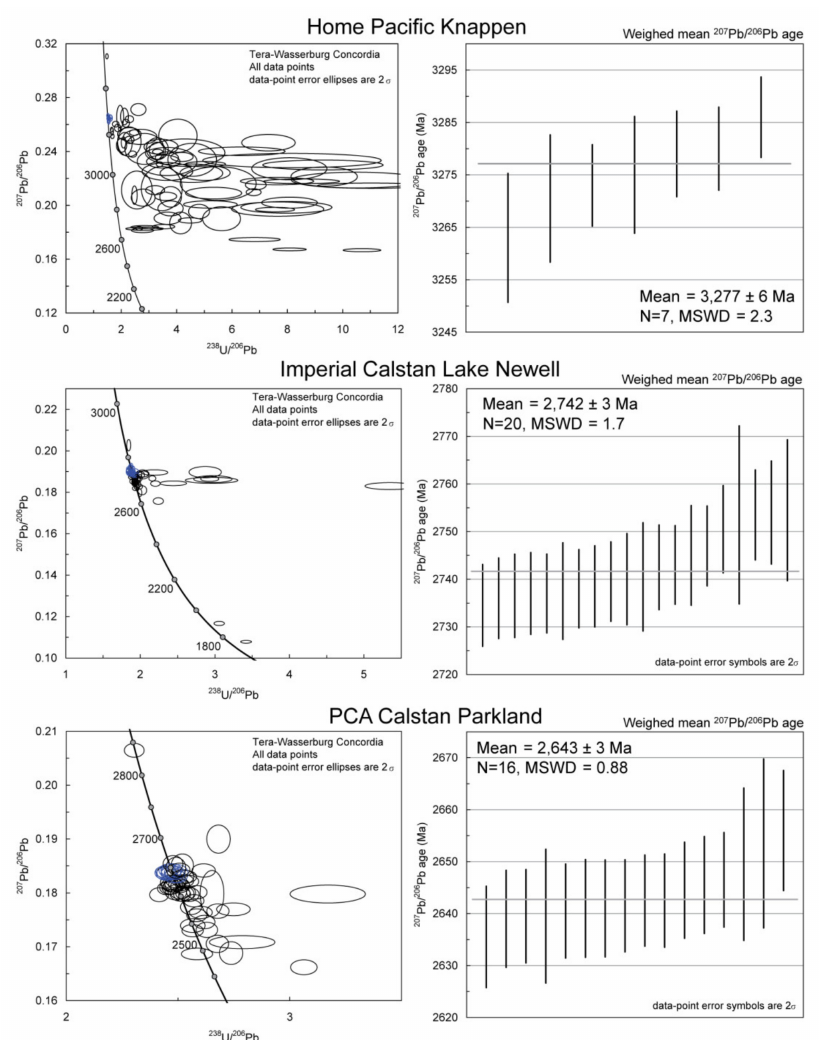
Figure 3. Unfiltered concordia plots of 207 Pb / 206 Pb versus 238 U / 206 Pb and corresponding ages showing the spread of zircons for samples analyzed in this study, and error-weighed mean 207 Pb / 206 Pb ages Home Pacific Knapppen, PCA Castalan Parkland, and Imperial Castalan Lake Newel samples. The analyses used for the error-weighted mean calculations are highlighted in blue. Plots, ages, and age statistics are from Isoplot 3.7. See text for full